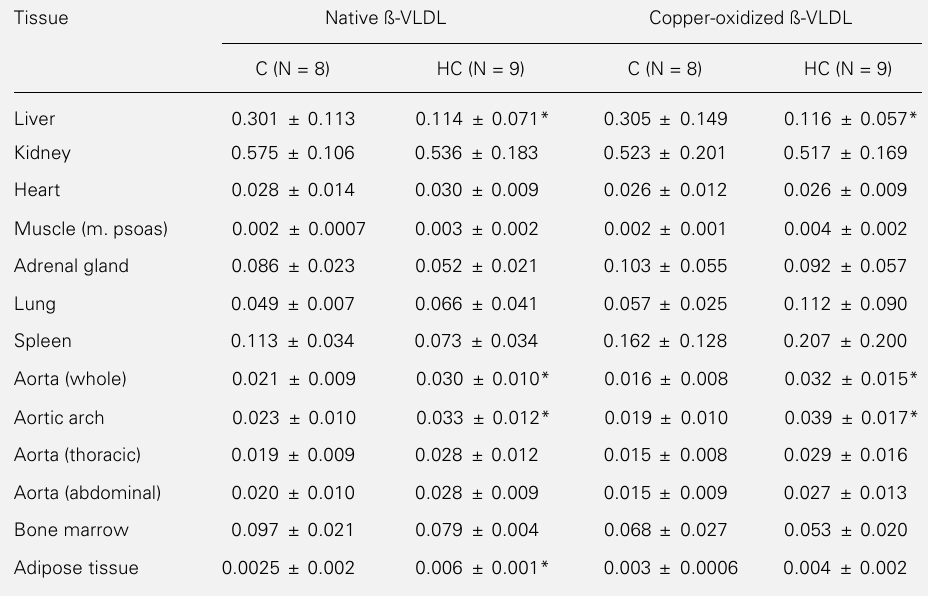
Table 3 - Biodistribution of 99m Tc-ß-VLDL in rabbits. Data are reported as means ± SD of results obtained from control (C) and hypercholesterolemic (HC) rabbits and are expressed as percentage of the injected radioactivity dose/g tissue. *P<0.05 compared to the respective C group (ANOVA and Scheffé test).